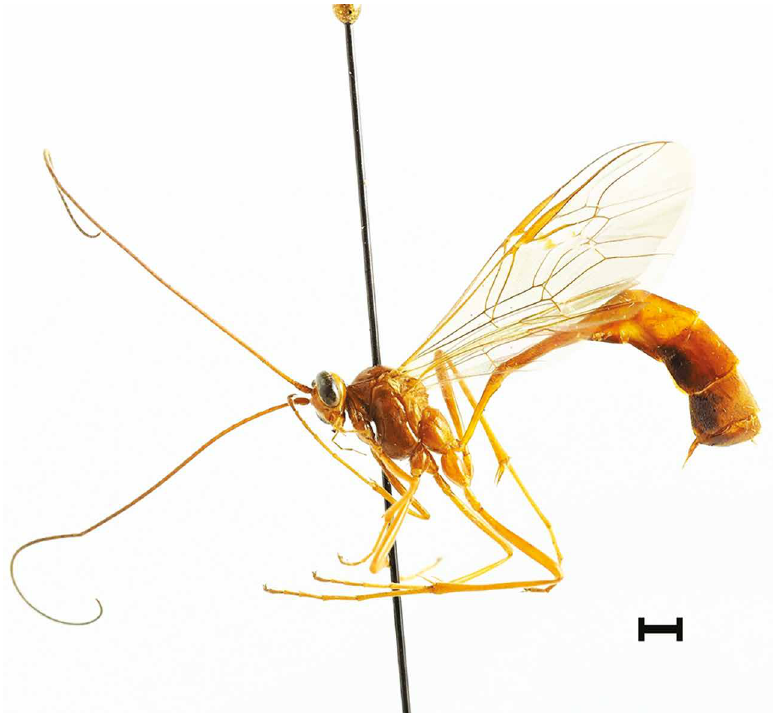
Fig. 11. Enicospilus ryrholmi sp. nov., holotype, ♀ (NHRS-HEVA000008172), habitus, lateral view. Scale bar = 1